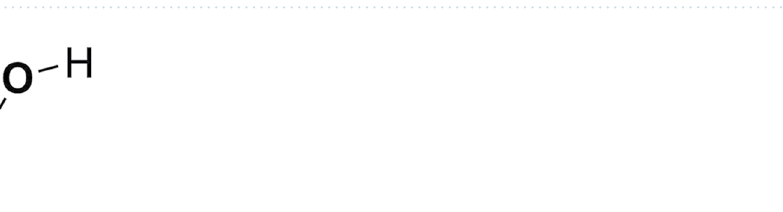
Figure 4. The coordination of the fluorine atom with the alcohol